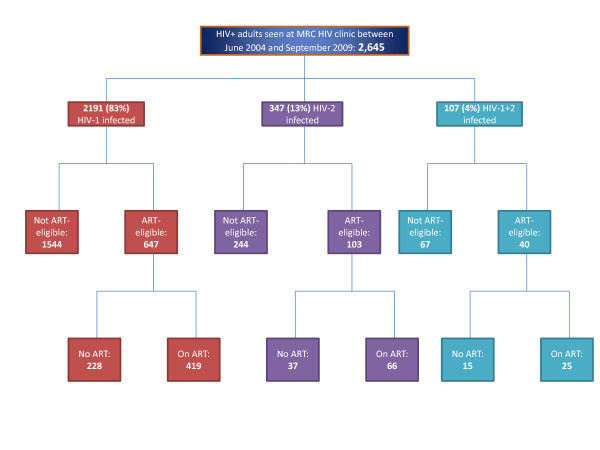
Profile of the MRC (UK) The Gambia adult HIV Cohort. Schematic diagram showing the number of HIV infected patients aged ≥15 years seen at the MRC HIV clinic between June 2004 and September 2009. There were 647 HIV-1, 103 HIV-2 and 40 HIV-1/HIV-2 dually infected patients eligible for ART during this period.